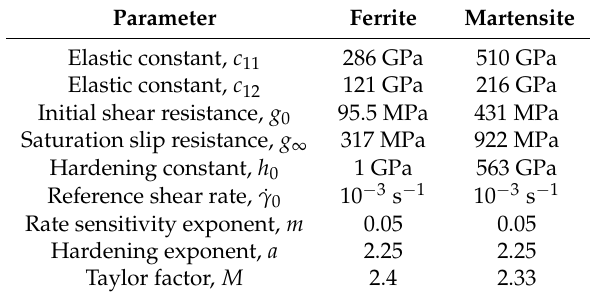
Table 4. Taylor factor ( M ) adapted isotropic plasticity ([16]) material parameters for ferrite and